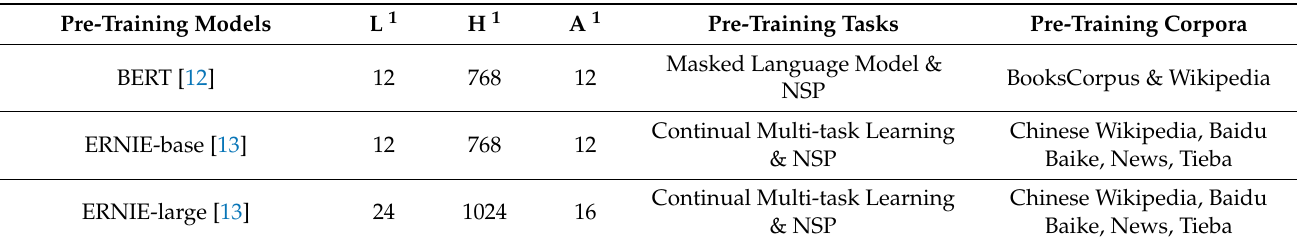
Table 2. Parameters, pre-training tasks, and corpora of BERT and